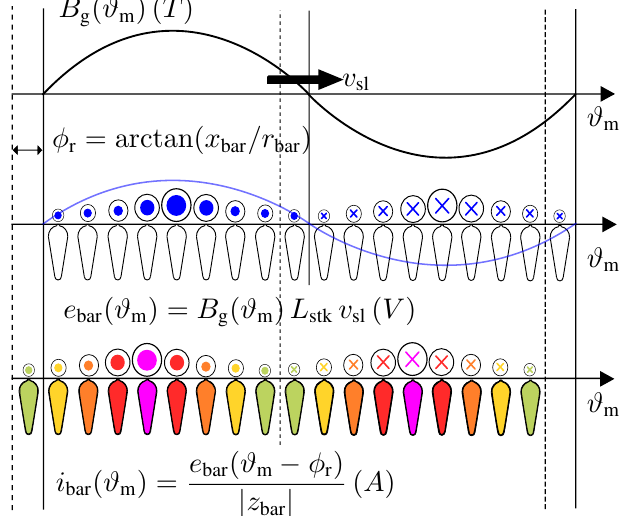
Figure 1. Induced voltage and current spatial distribution in the slots of a squirrel cage rotor when the air-gap flux density B g is sinusoidal. v sl indicates the relative speed between the stator field and the rotor; z bar = r bar + j x bar is the bar impedance; i bar and e bar are the bar-induced voltage and current; L stk is the stack